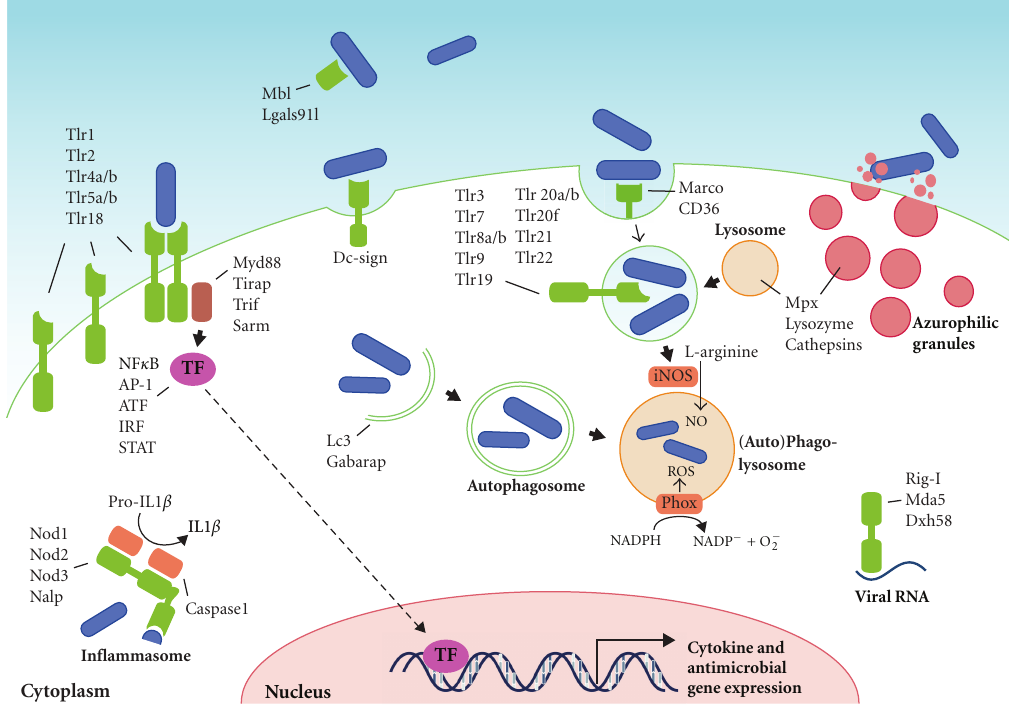
Figure 1: Pattern recognition receptors and e ff ector mechanisms of the innate immune system. The localization of Tlrs on the cell surface or on endosomes is hypothetical and based on the known or proposed functions of their homologs in other fish or mammals. The ability of PRRs (depicted in green) to recognize PAMPs present on various types of microorganisms, like bacteria, viruses, and fungi, has been simplified here by depicting microorganisms as rod-like bacteria (in blue). PAMP recognition by PRRs leads to activation of transcription factors (TFs), which translocate to the nucleus and initiate transcription of cytokine genes, antimicrobial genes, and other immune-related genes. Defense mechanisms such as autophagy, ROS and NO production, and degranulation can be immediately activated upon microbial recognition, without de novo gene